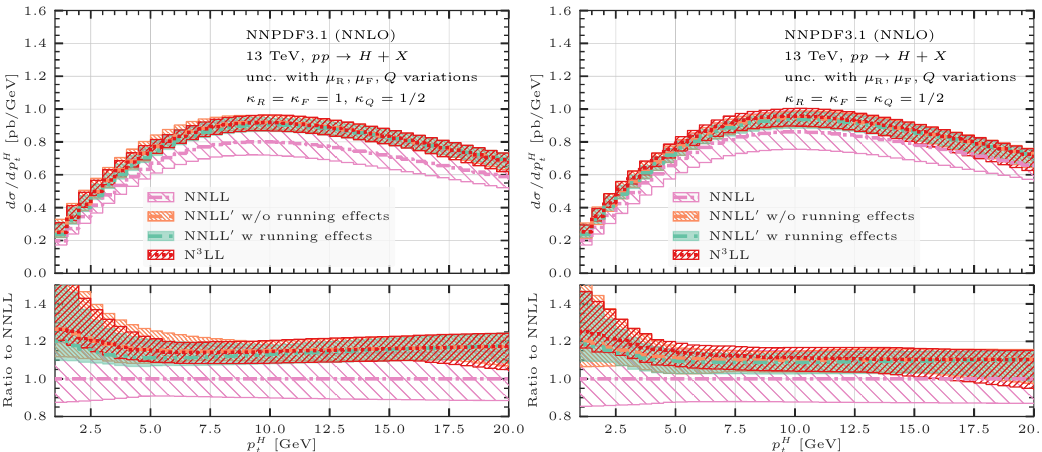
Figure 6 . Resummed p H spectrum for inclusive Higgs production at NNLL, NNLL 0 , N 3 LL. Left t panel: central scales κ R = κ F = 1 , κ Q = 1 / 2 . Right panel: central scales κ R = κ F = κ Q = 1 / 2